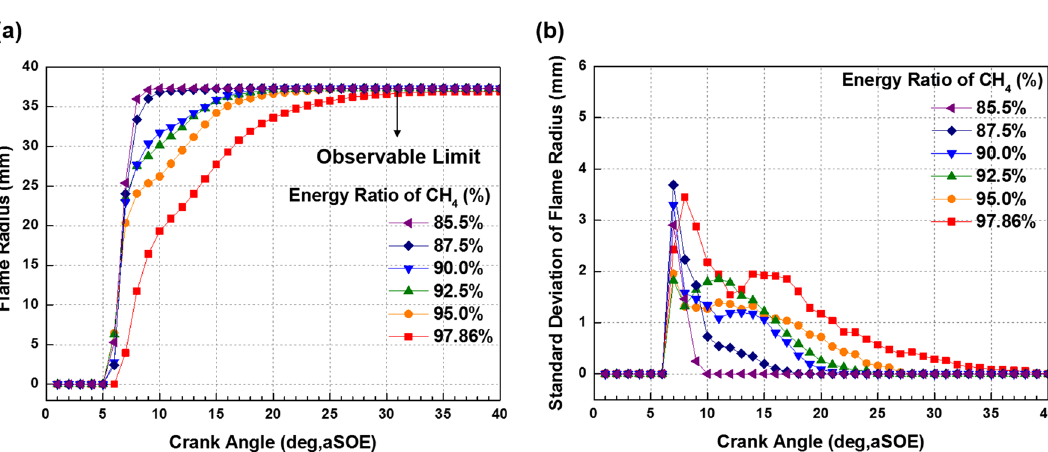
Figure 17. (a) Flame radius and (b) variation with respect to the fuel mixture